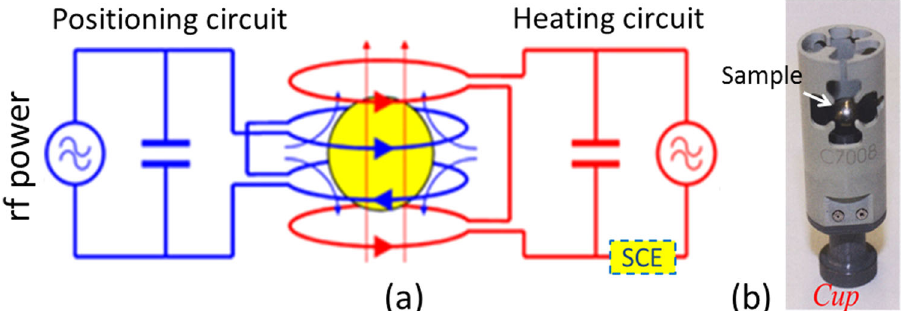
Fig. 8 a Scheme of the EML facility consisting of a positioner coil ( blue ), the rf current through which generates an electromagnetic quadrupole fi eld, and a separated heater coil ( red ), the rf current through which generates an electromagnetic dipole fi eld. Included in the heating circuit is the sample coupling electronics (SCE) sensing feedback signals from the sample. b Picture of the ceramic cup sample holder enclosing the sample for safety reasons (taken from ref.